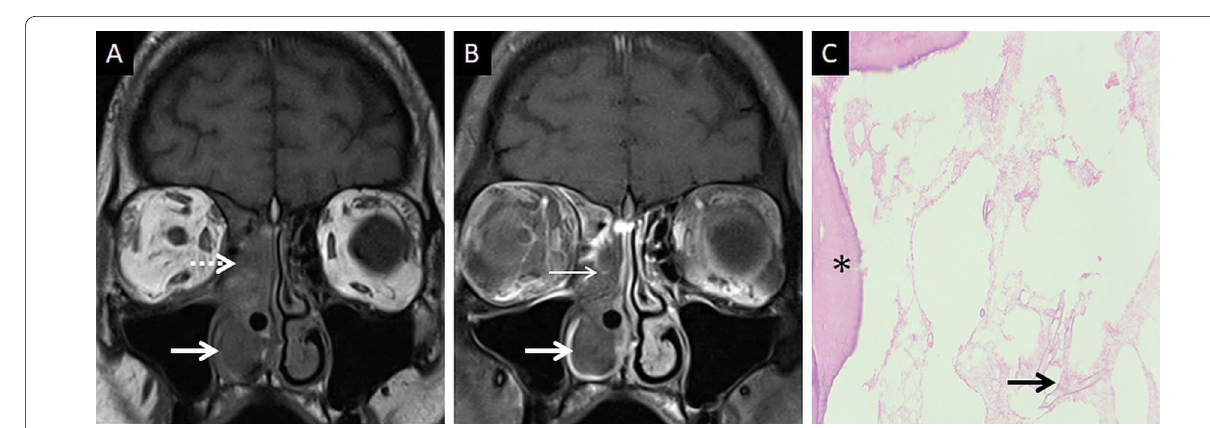
Fig. 5 Classic appearance of the “black turbinate” sign. Unenhanced coronal T1W image ( a ) reveals intermediate signal contents within the right nasal cavity (dotted arrow) and hypertrophy of the right inferior turbinate (thick arrow). Corresponding CE fat-suppressed (FS) coronal T1W image ( b ) reveals poor enhancement of the right middle (thin arrow) and inferior turbinates (thick arrow) due to necrosis, resulting in the “black turbinate” sign. Post-operative histopathology analysis ( c ), using HE staining, demonstrates necrosis of the turbinate (*) and branching, aseptate fungal hyphae (thick arrow) consistent with the diagnosis of